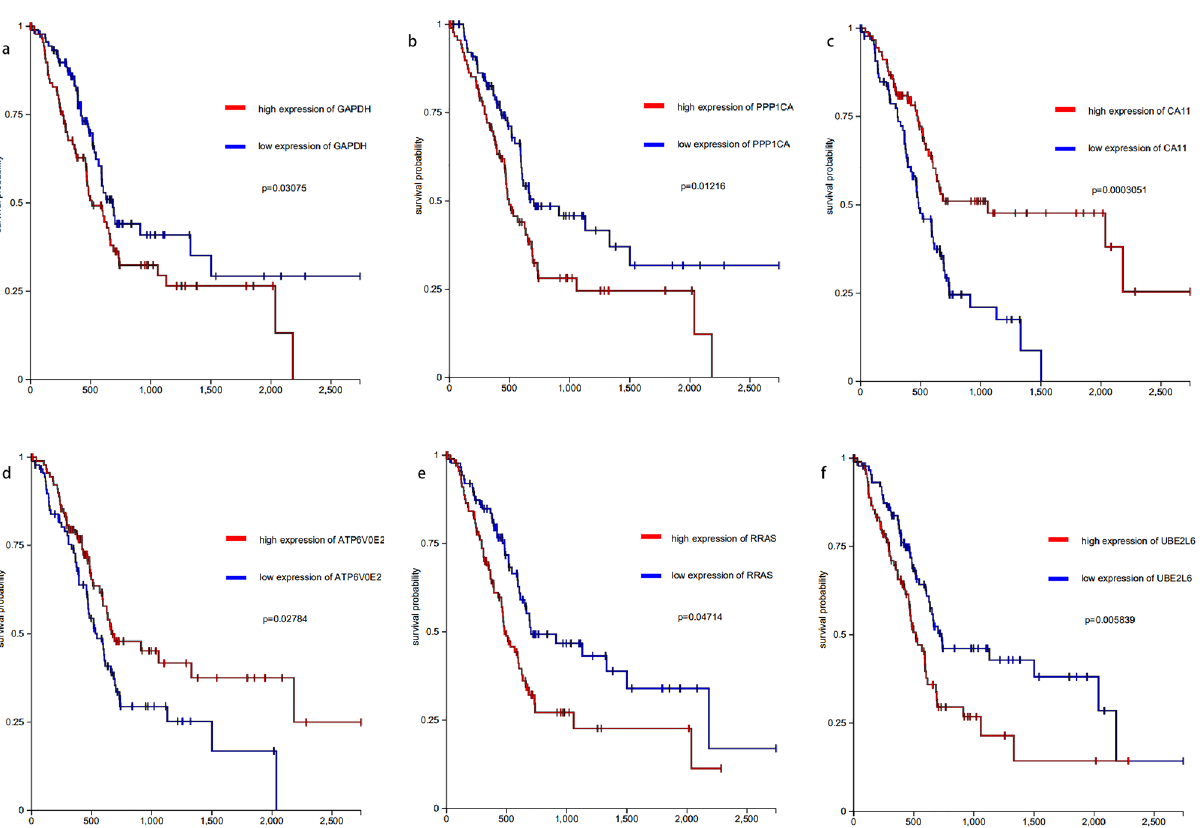
Figure 9. The survival correlation of predicted genes. ( a ) GAPDH; ( b ) PPP1CA; ( c ) CA11; ( d ) ATP6V0E2; ( e ) RRAS; ( f )